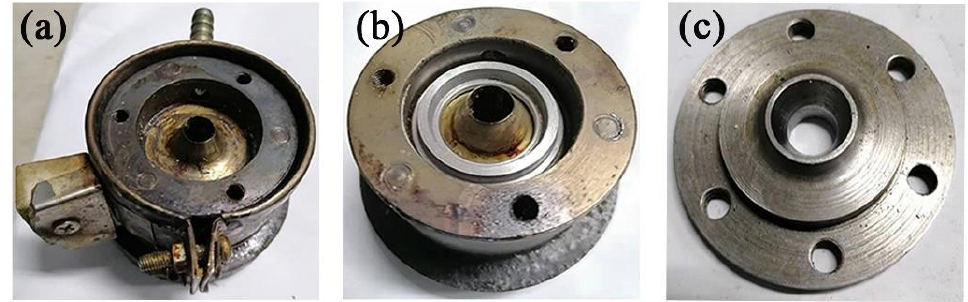
Figure 9. Gas-assisted extrusion experimental equipment.